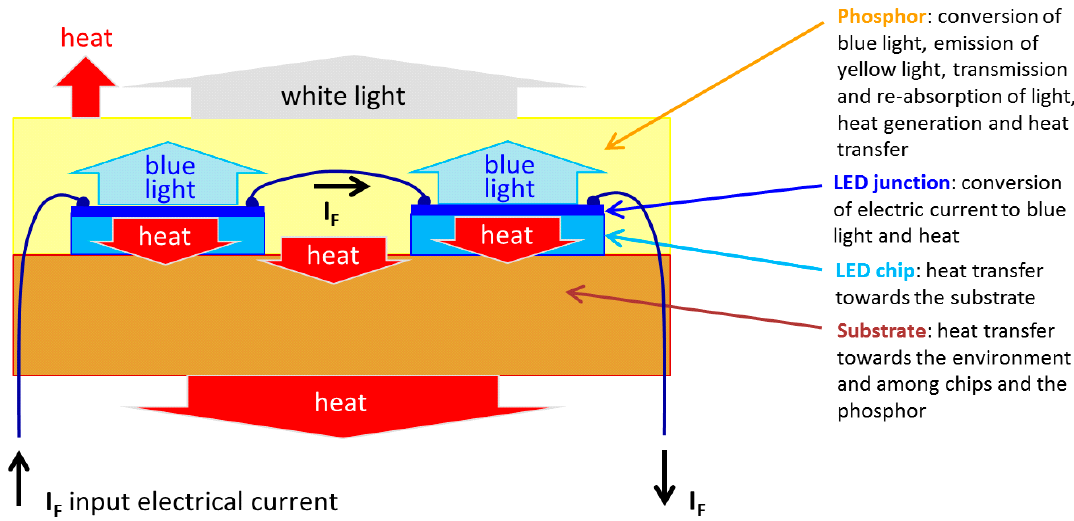
Figure 1. Overview of the physical processes in different, major structural elements of a phosphor-converted white chip-on-board (CoB) LED device to be captured by dedicated simulation models.